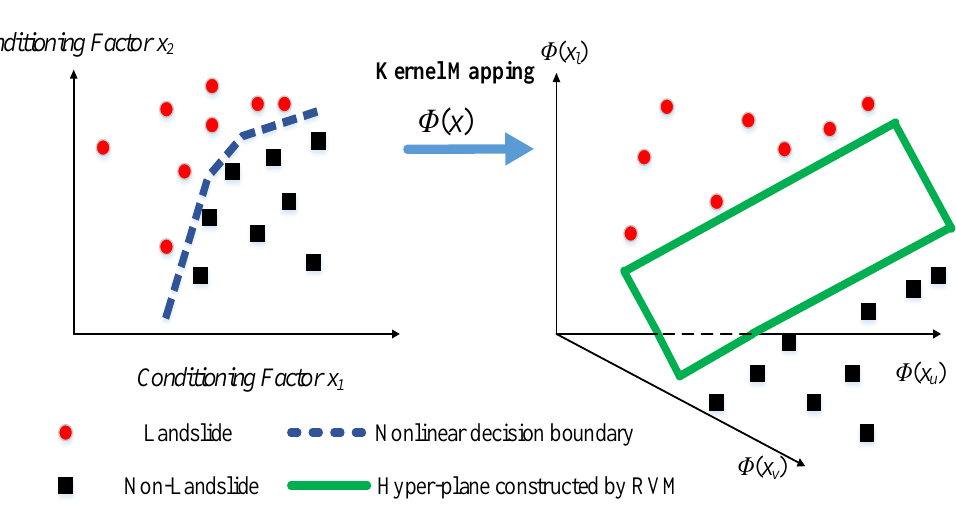
Figure 4. Illustrated concept of RVM classification model [114].